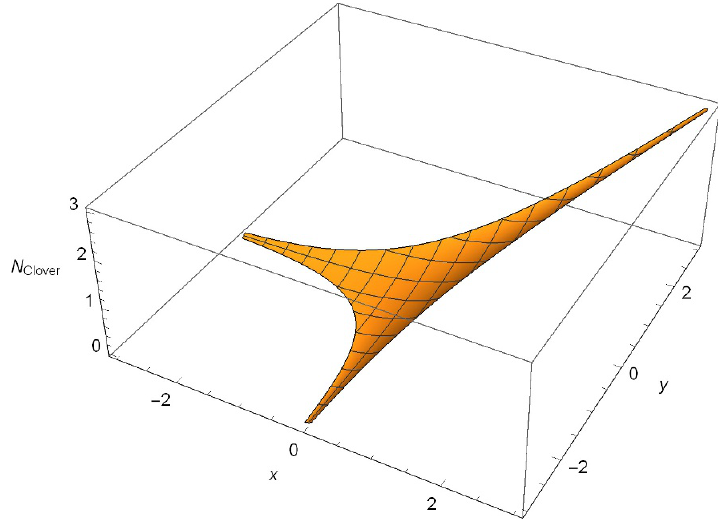
Figure 3 . Pro(cid:12)le of clover